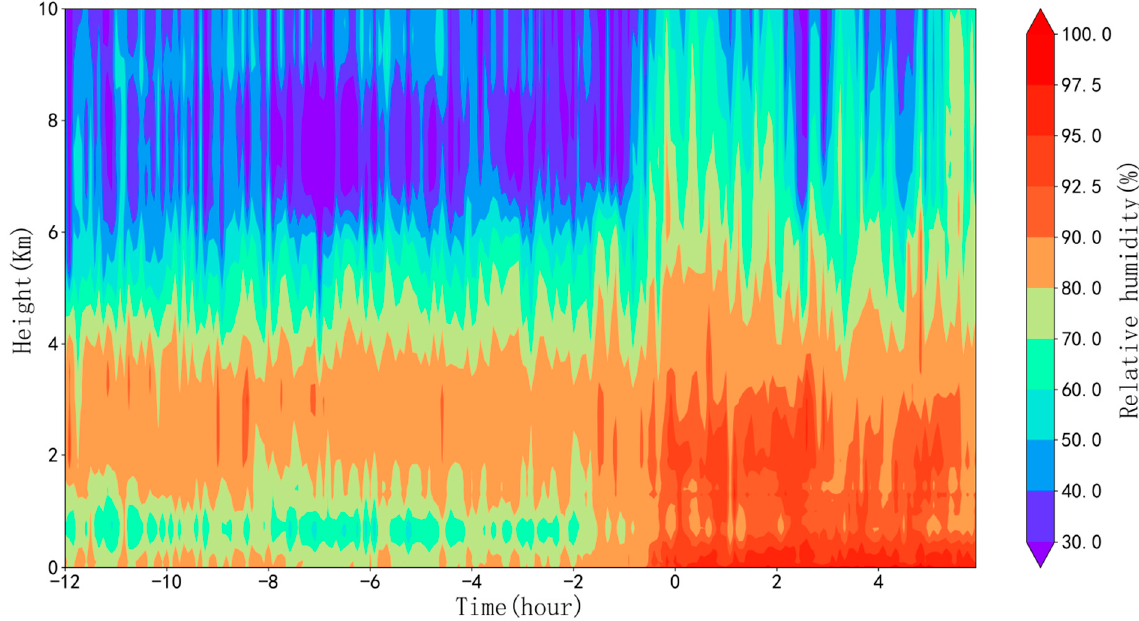
Figure 6. Vertical distributions of relative humidity during 12 h before and 6 h after the start of MDPs in 2021.